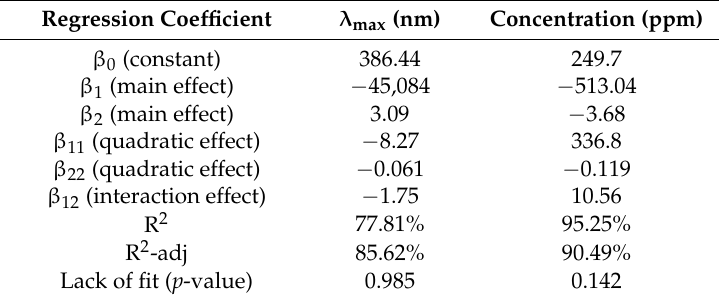
Table 2. Regression coefficients, R 2 , R 2 -adj, and probability values for the fitted models.